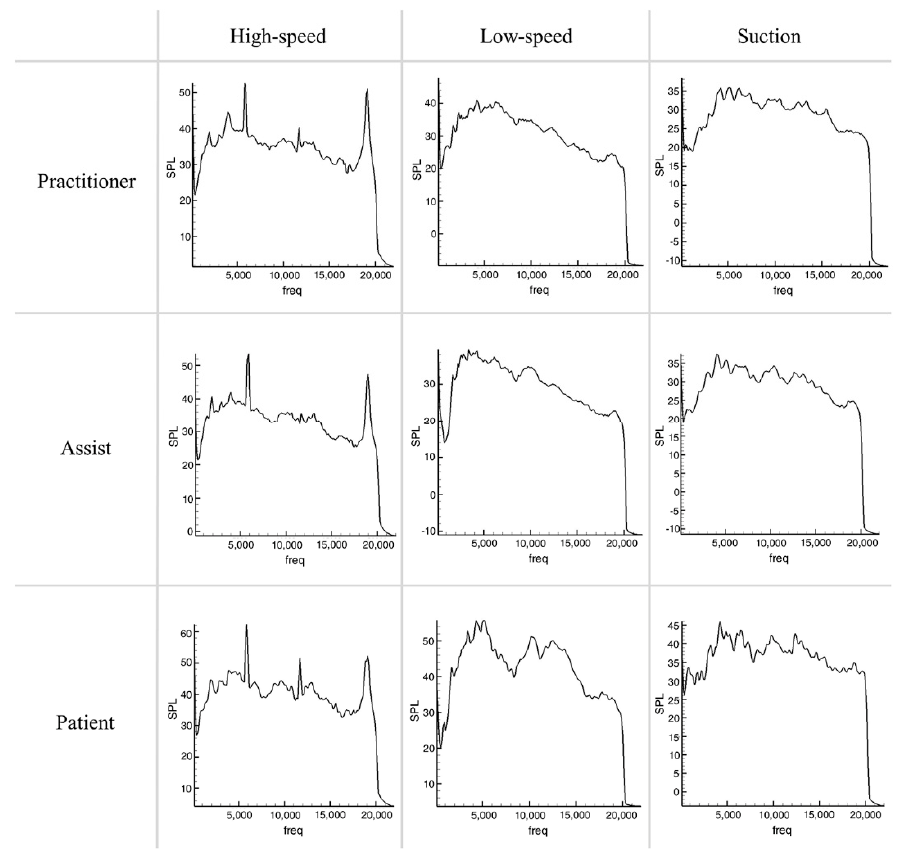
Figure 2. Sound pressure level graphs of dental noise from high − speed, low − speed, and suction without tooth preparation.